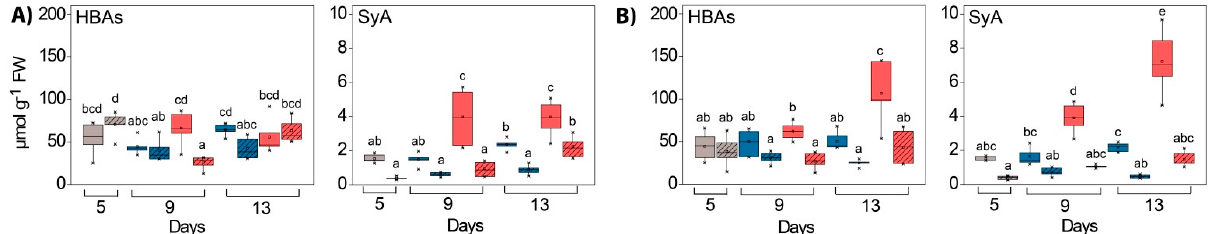
Figure 4. Changes in the composition of total hydroxybenzoic (HBA) and syringic acid (SyA) in GL (solid boxes) and WL (striped boxes) of P. zonale plants before (5 d, grey) and after four (9 d) and eight days (13 d) of high light exposure (HL, 800 µmol m –2 s –1 , red bars) compared to plants exposed to low light (LL, 180 µmol m –2 s –1 , blue bars) at ( A ) optimal temperature of 25 °C ( HL ) and ( B ) lower temperature of 18 °C ( Cold + HL ). Values are shown in µmol g –1 FW ± SE, n = 5–9. Different letters indicate statistically significant differences between different PAR intensities, time points, and leaf tissues ( p < 0.05) according to Tukey’s post hoc test.